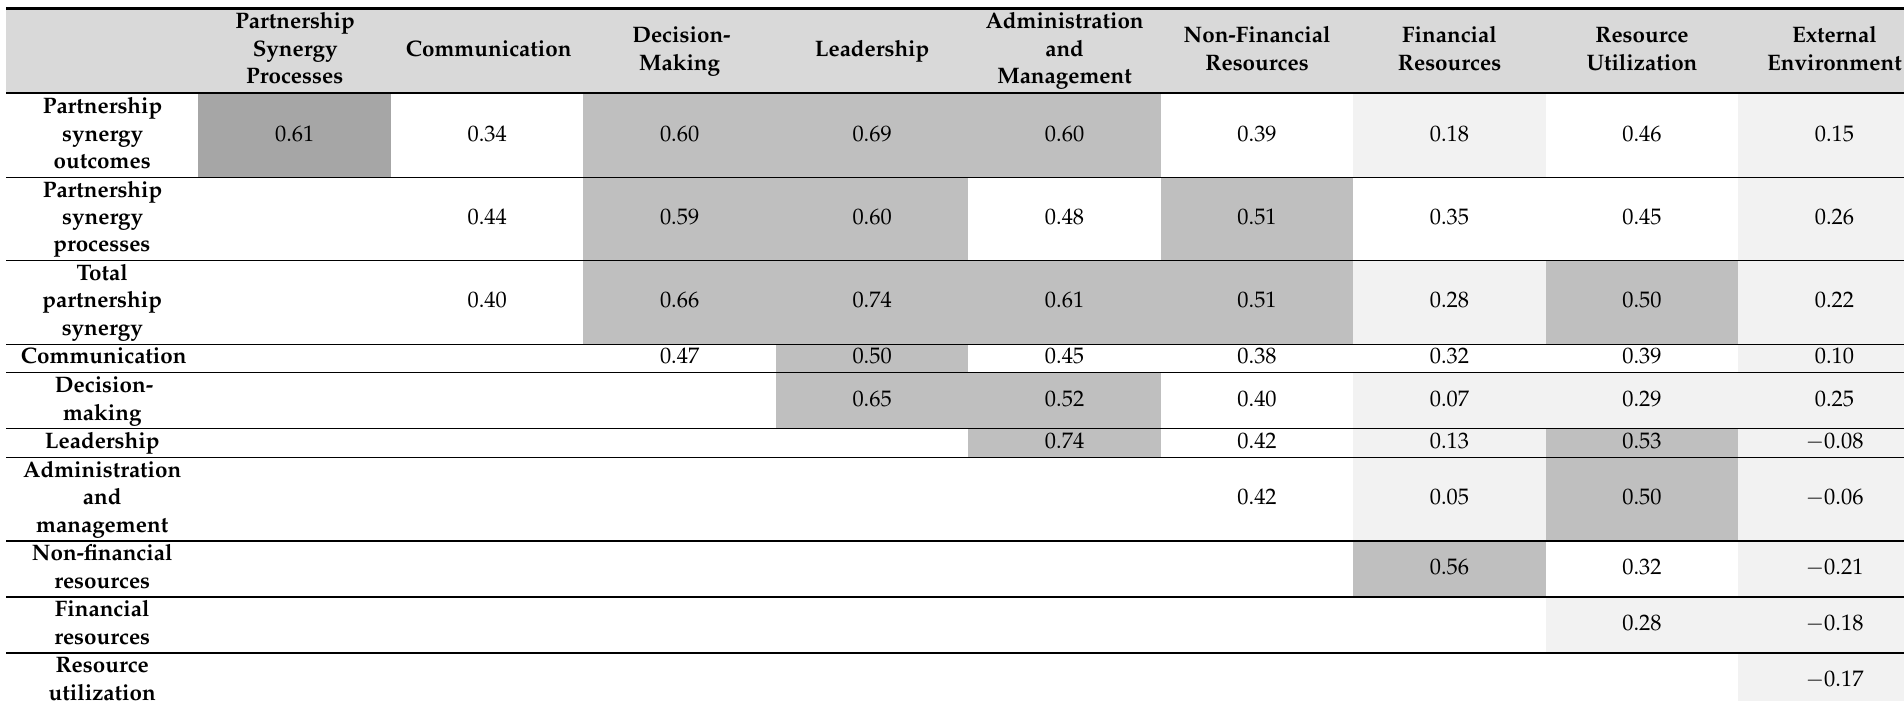
Table 3. Spearman rank correlations among partnership synergy outcomes, partnership synergy processes, total partnership synergy and the different partnership assets and processes ( n = 54). Values shaded in light grey denote weak correlations and in dark grey strong correlations (adapted from